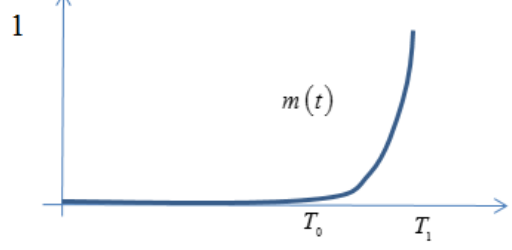
Figure A1. Weight function signifying that gelling is initiated when nanomaterials have age T 0 and when gelling reaches maximal strength at age T 1